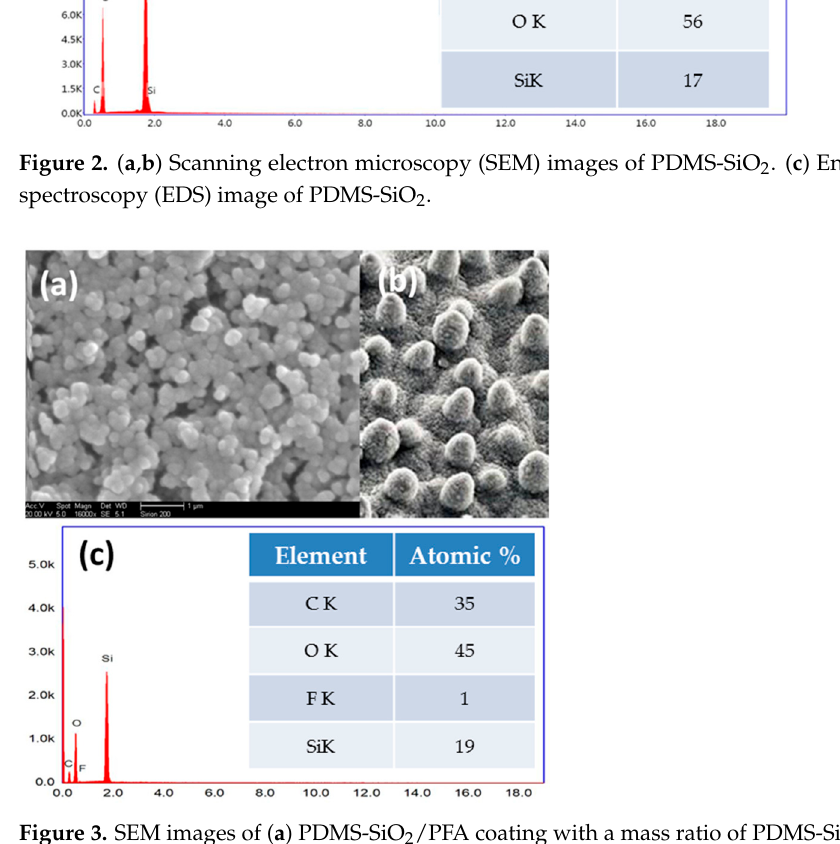
Figure 3. SEM images of ( a ) PDMS-SiO 2 /PFA coating with a mass ratio of PDMS-SiO 2 to PFA of 0.5 and ( b ) lotus leaf surface. ( c ) EDS image of PDMS-SiO 2 /PFA coating with a mass ratio of PDMS-SiO 2 to PFA of 0.5.